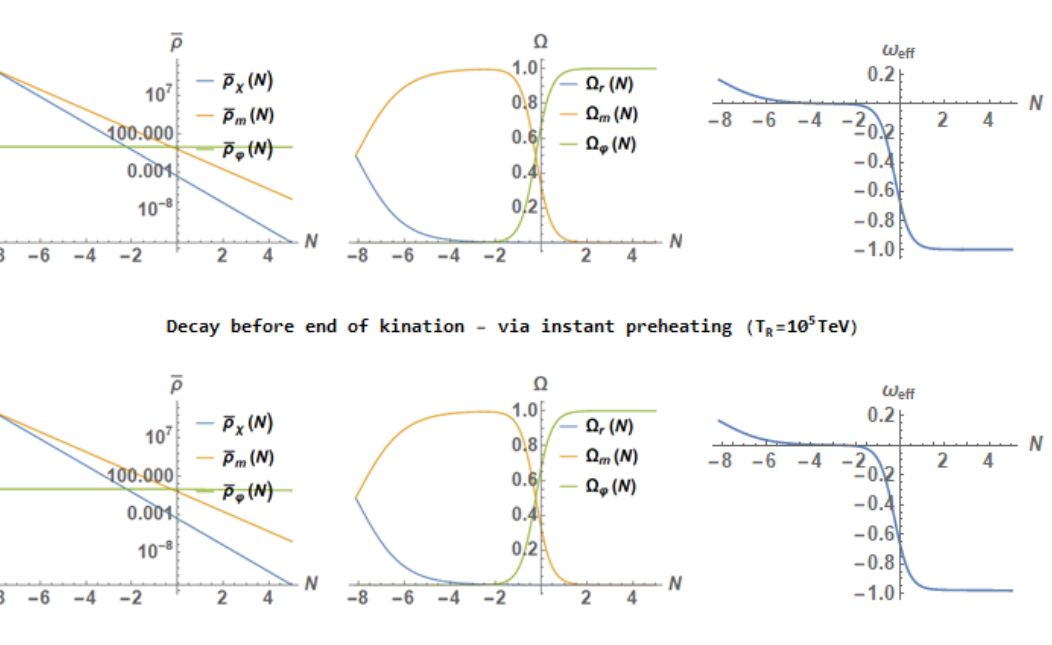
Figure 2. Numerical results for the allowed reheating mechanisms for the potential in